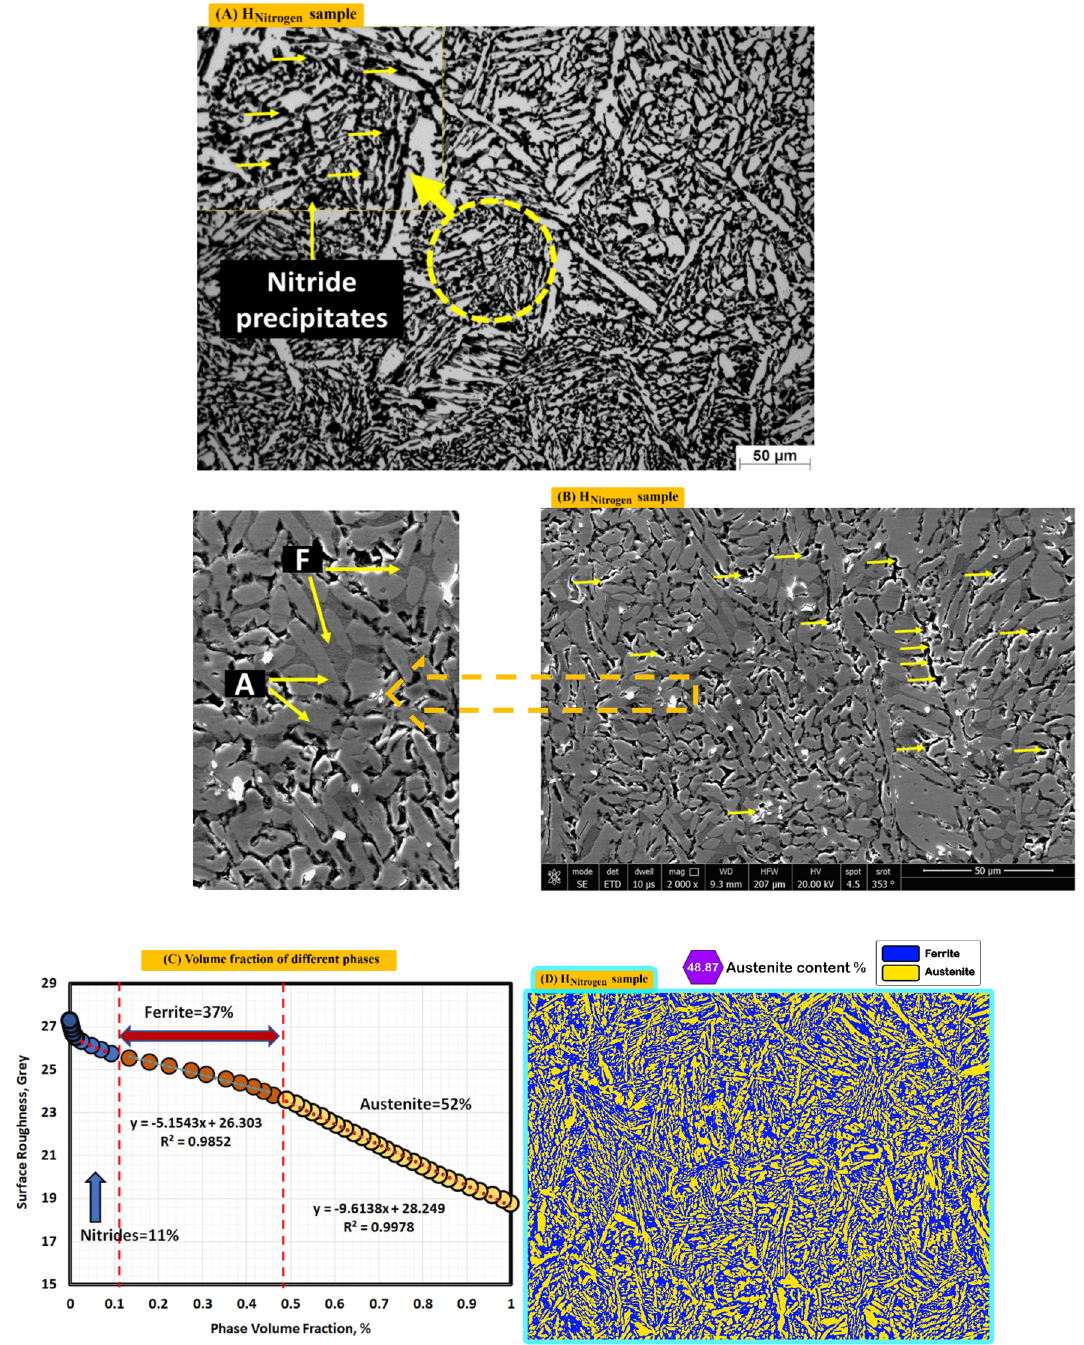
Figure 9. Optical, SEM micrographs and different volume fraction for weld zones of sample (H Nitrogen ) protected with Nitrogen gas during PWHT process ( A ) optical microstructure, ( B ) SEM photo, ( C ) volume fraction by MATLAB software, and ( D ) austenite content of one random image of weld zone by image J